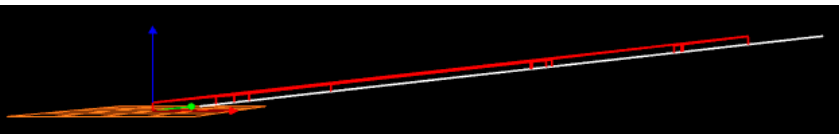
Figure 16. The rendered tool path in the XZ-axis.